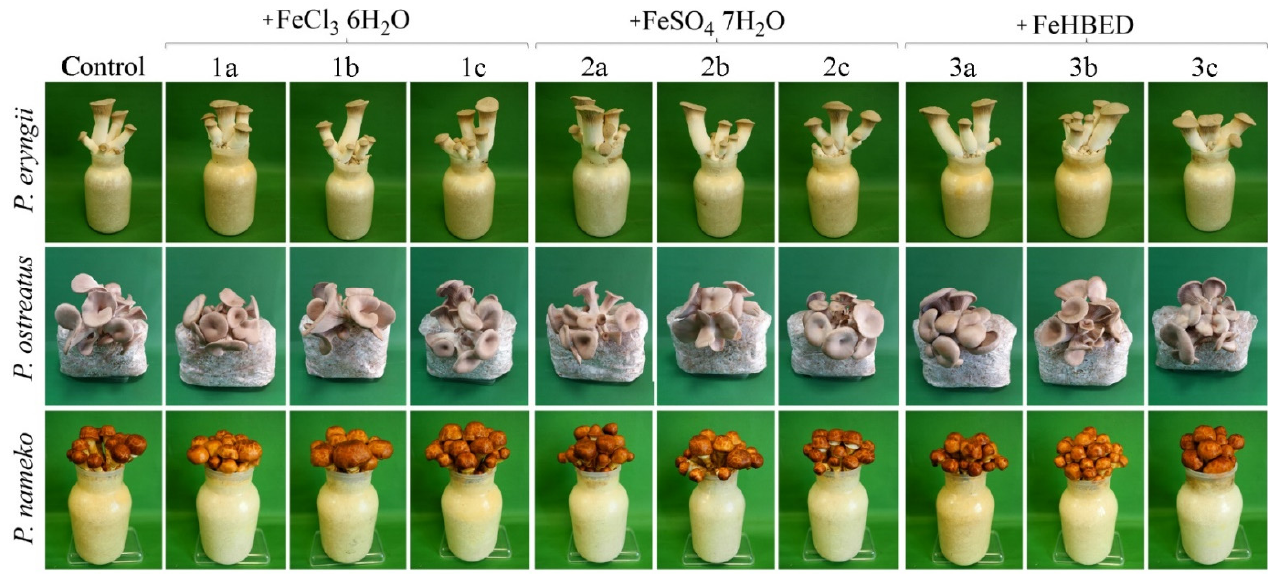
Figure 1. Macroscopic characteristics of control and treated fruit bodies growing on substrate enriched with FeCl 3 6H 2 O (1), FeSO 4 7 H 2 O (2), and FeHBED (3) in concentrations of 5 (a), 10 (b), and 50 (c) mM.